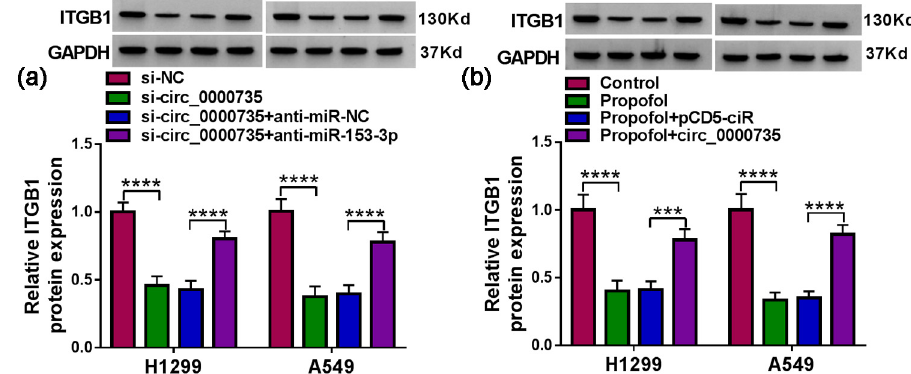
Figure 7: Propofol regulated ITGB1 expression via the circ_0000735/miR - 153 - 3p axis. ( a ) Western blotting analysis of the e ff ect of miR - 153 - 3p inhibitor on the protein level of ITGB1 in si - circ_0000735 - transfected NSCLC cells ( n = 3 ) . ( b ) Western blotting evaluation of the e ff ect of circ_0000735 upregulation on the protein level of ITGB1 in propofol - treated NSCLC cells ( n = 3 ) . *** P < 0.001 and **** P <